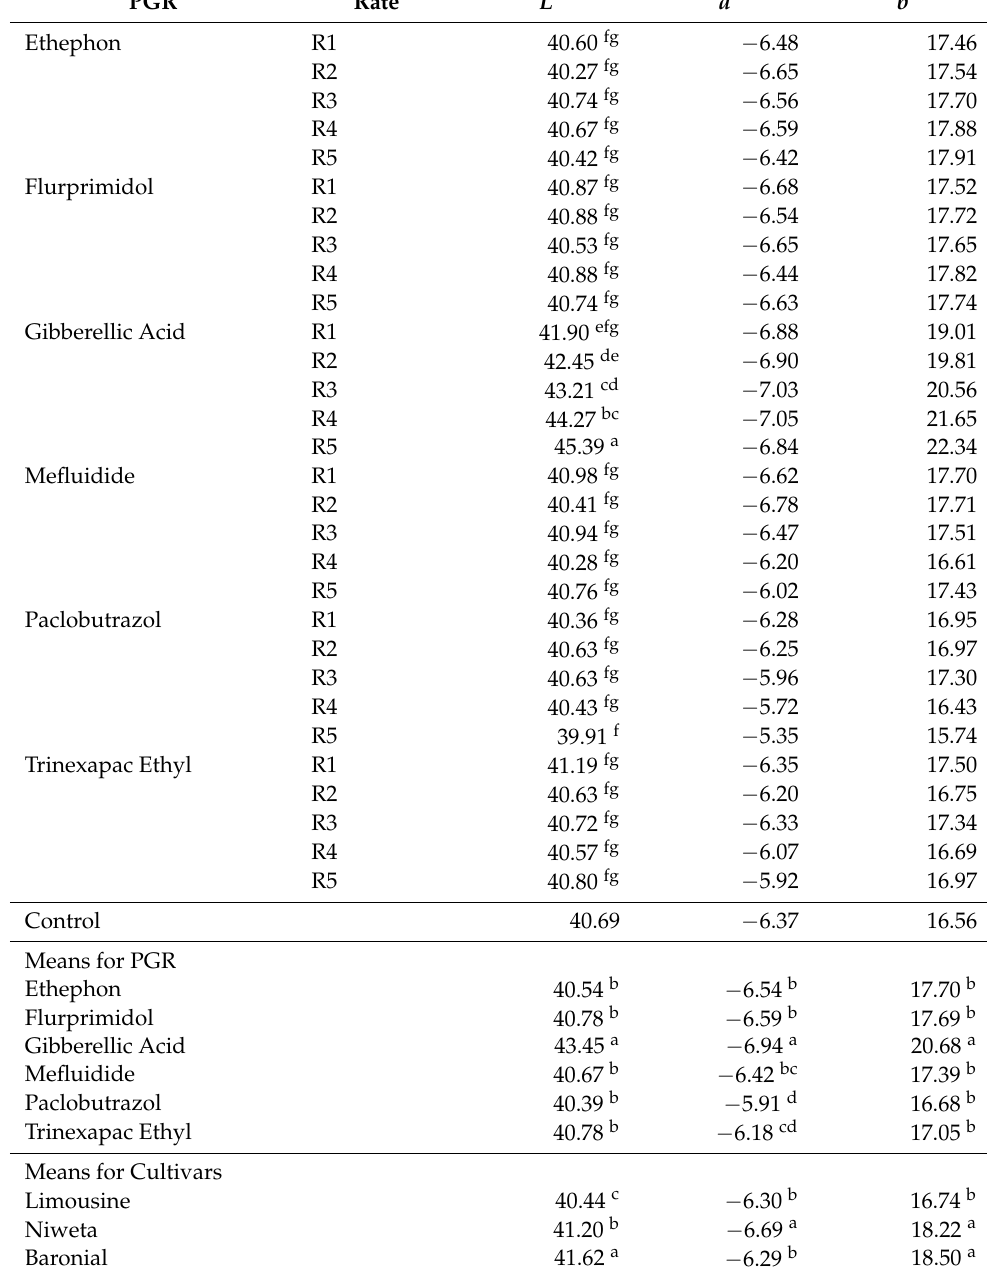
Table 2. Effect of PGR application on Kentucky bluegrass color CIE Lab